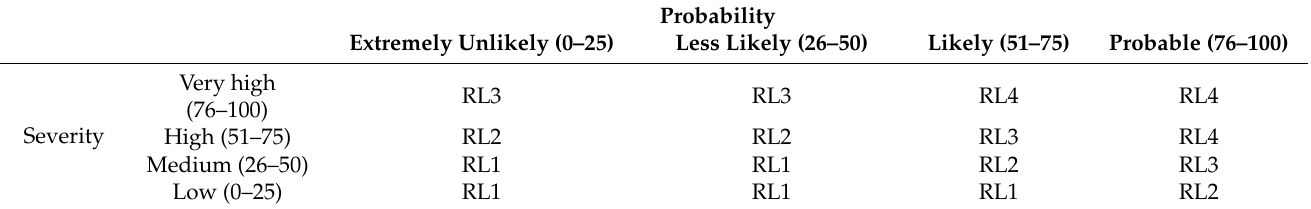
Table 1. Risk level